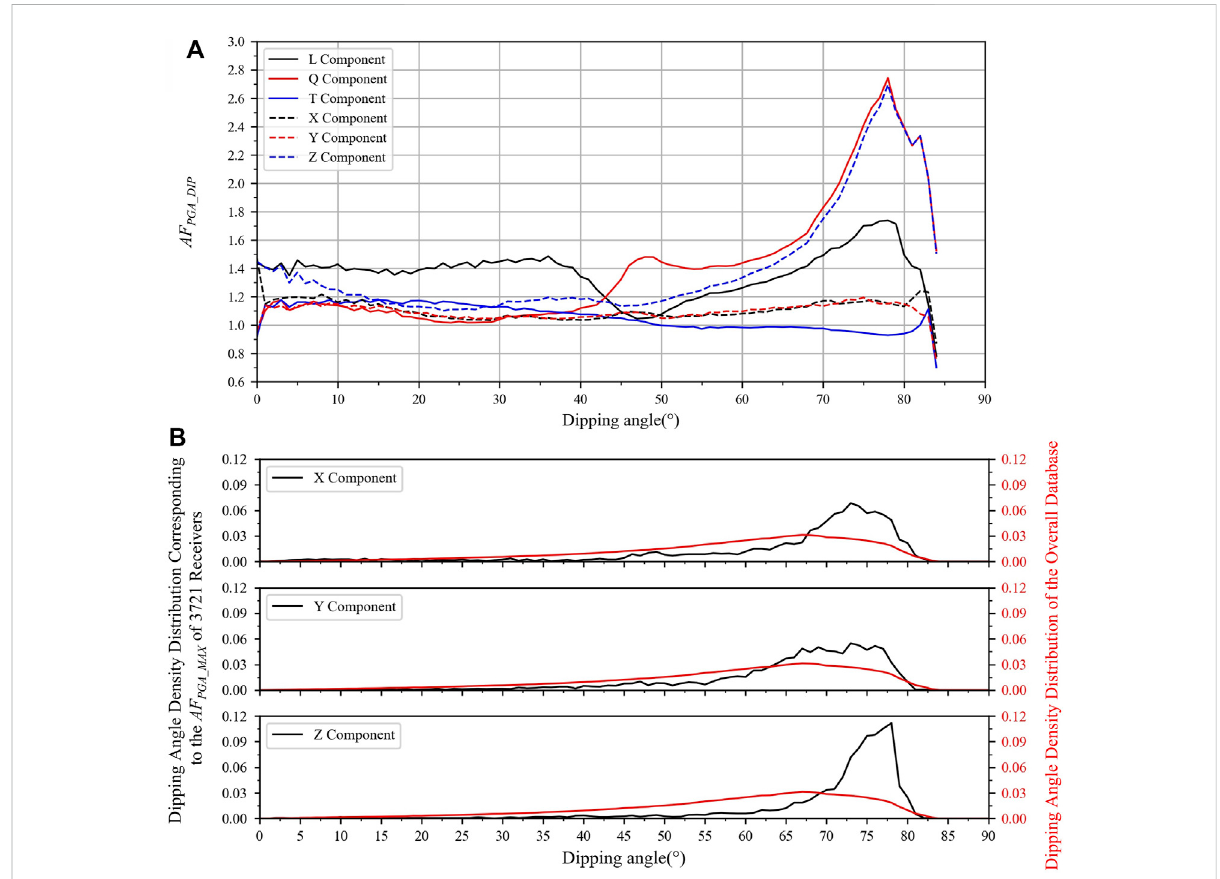
FIGURE 5 Thein fl uenceofdippingangleon AF PGA . (A) Therelationshipof AF PGA DIP withdippingangle,taking1 ° astheinterval; (B) Thedensitydistribution of dipping angle.